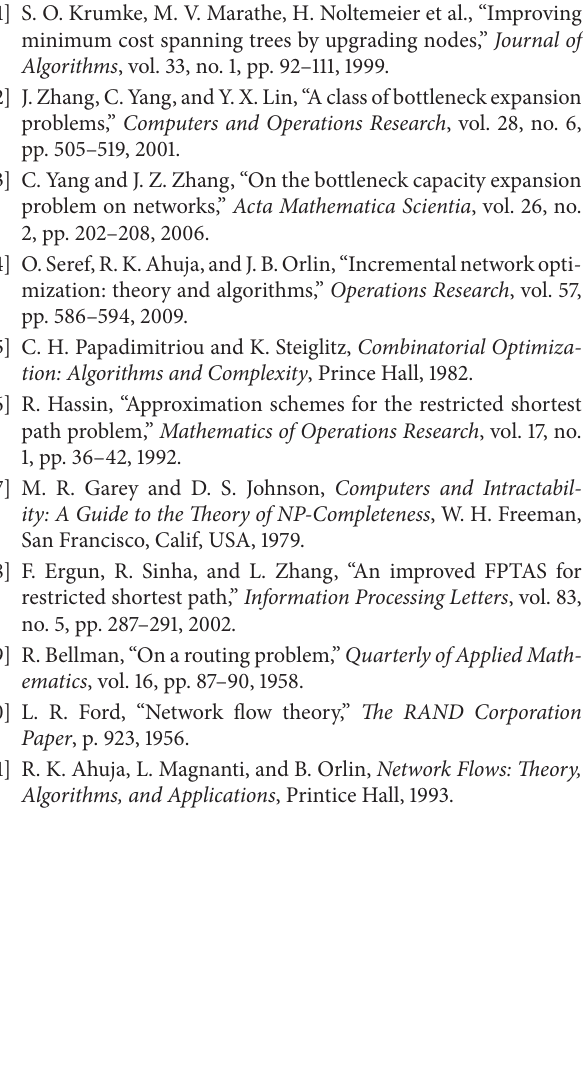
Algorithm 6 (MCESP). Comment . Return the minimum-cost capacity expansion shortest